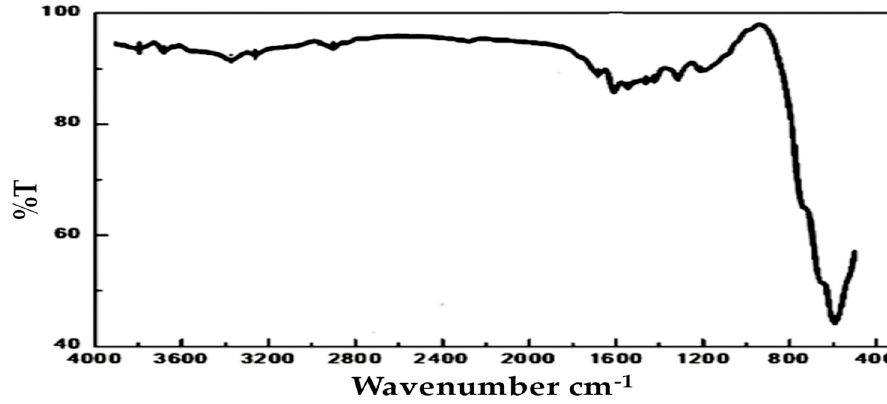
Figure 4. FTIR spectrum of CoO/Co 3 O 4 nanoparticles.